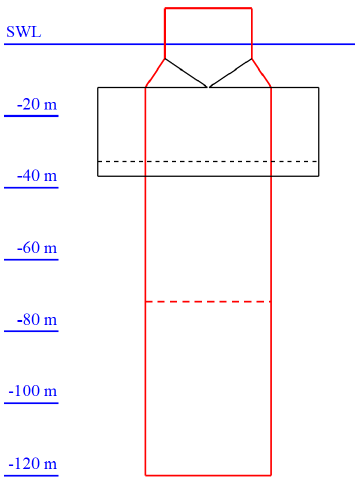
Figure 8. The best-performing floater geometry (black) in compar- ison to the original shape (red).